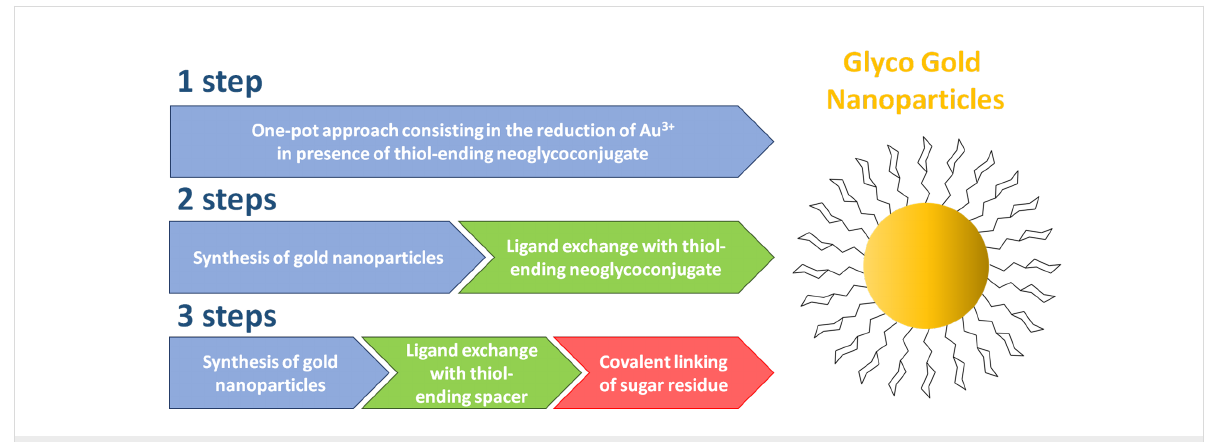
Figure 1: Schematic overview on the glyco-gold nanoparticles synthetic